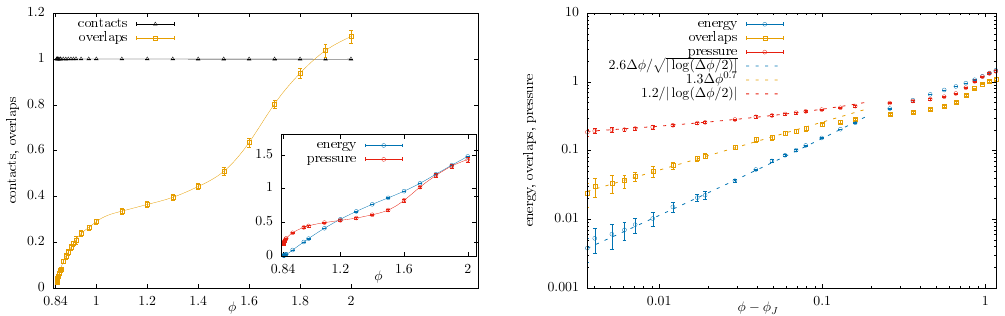
Figure 2: Left Panel . Main plot: the isostaticity index defined as c = C / ( Nd − d ) = O / ( Nd − d ) as a function of the packing and the fraction of overlaps defined as n O (cid:39) 0.84). Inset: Behavior of energy fraction (we find the jamming transition at φ J and pressure for φ > φ . Energy, pressure and number of overlaps are increasing J functions continuous at jamming. Data produced with system size N = 512, dimen- sions d = 2, averaged over ∼ 40 samples for each point. Right Panel. The behavior of pressure, energy and overlaps close to the unjamming transition. We attempted (cid:112) (cid:112) some logarithmic fits of the form e ∼ | ∆ φ | / log ( ∆ φ/ 2 ) , p ∼ 1 / log ( ∆ φ/ 2 ) and ∼ | ∆ φ | ν e . The unjamming packing fraction φ n is extracted from the fit of the O J